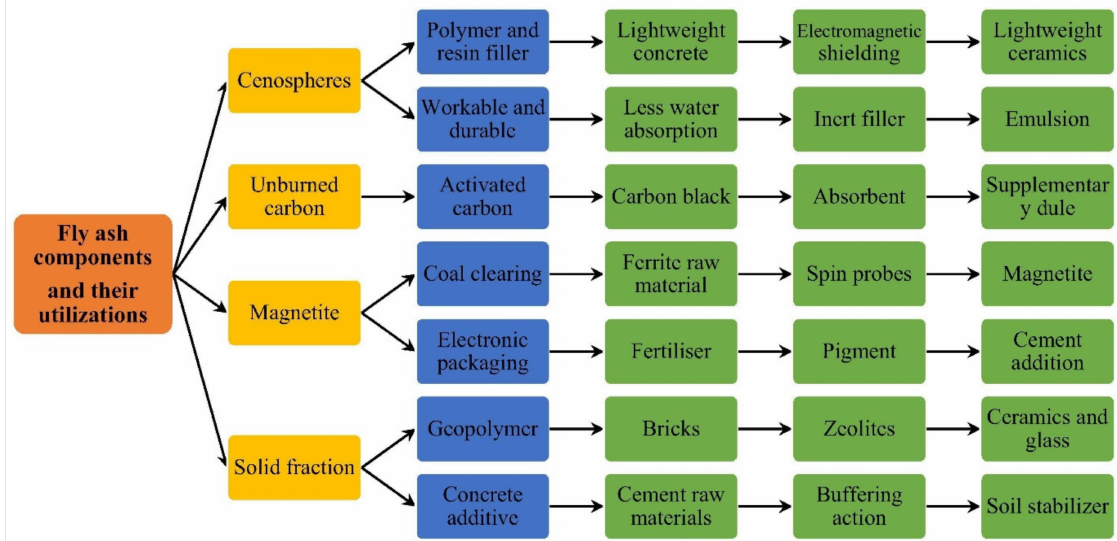
Figure 7. The utilization of fly ash and its components into different real-life applications. Reprinted with permission from Ref. [41]. Copyright 2021, with permission from Elsevier.